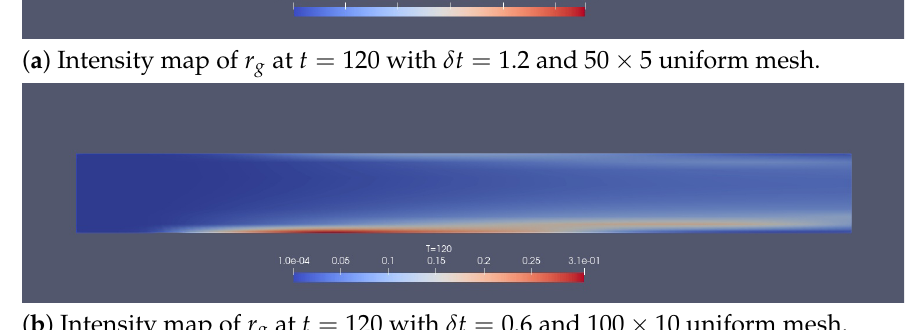
( b ) Intensity map of r g at t = 120 with δ t = 0.6 and 100 × 10 uniform mesh.